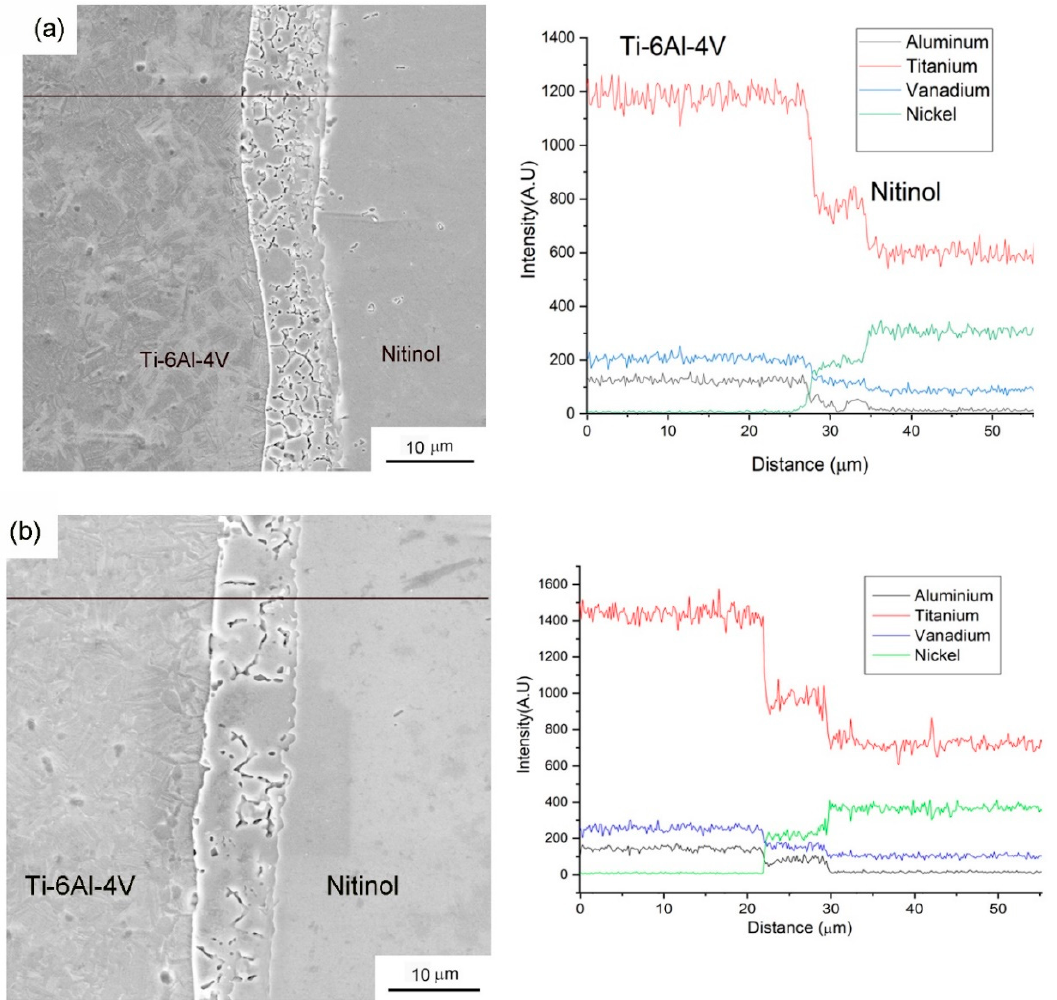
Figure 8. Scanning electron microscopy image in secondary electron mode showing ( a ) Ti-6Al-4V/Nitinol weld interface in the as-welded condition (left) and the corresponding energy dispersive spectroscopy (EDS) line scan. ( b ) Ti-6Al-4V/Nitinol weld interface after heat treatment (left) and the corresponding energy dispersive spectroscopy (EDS) line scan.